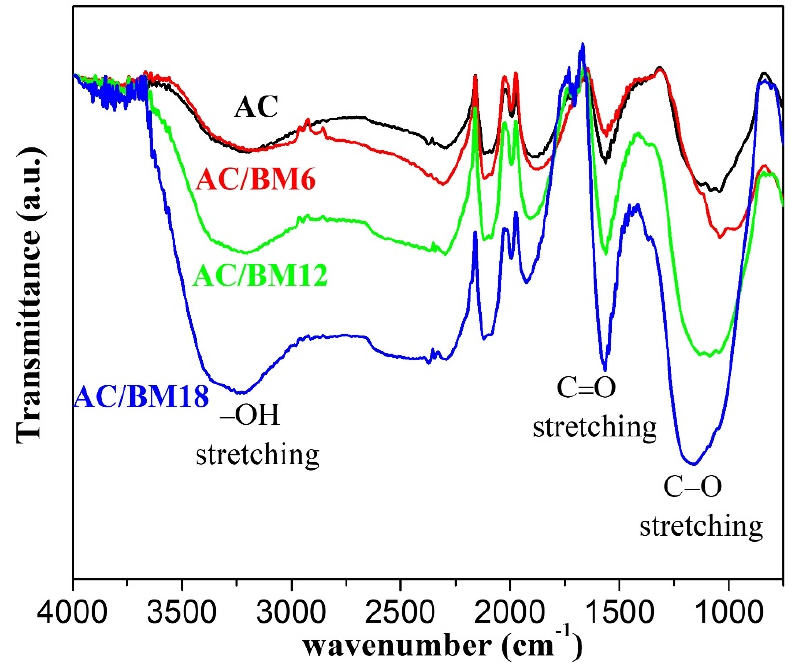
Figure 6. FT-IR spectra of the AC, AC/BM6, AC/BM12 and AC/BM18 Figure 6. FT ‐ IR spectra of the AC, AC/BM6, AC/BM12 and AC/BM18 samples.